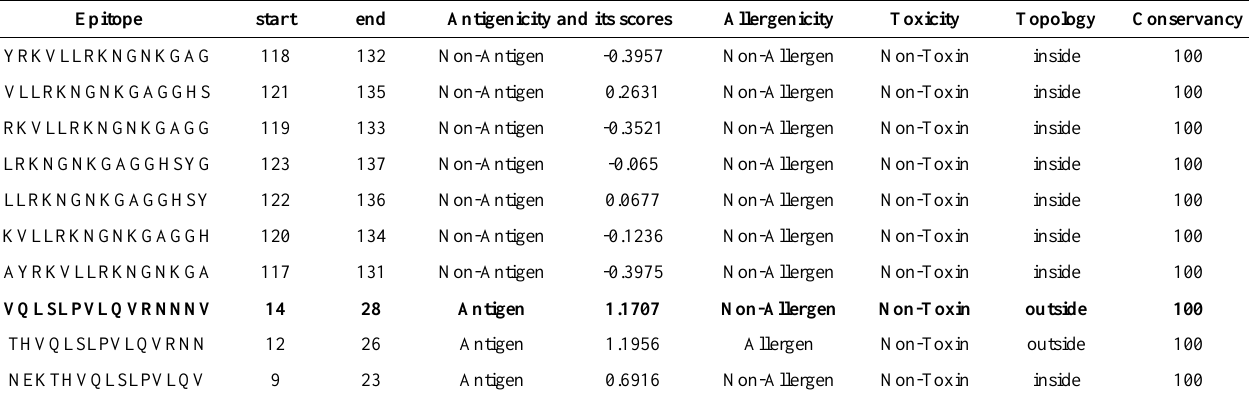
Table 7. List of MHC Class-II epitopes for selected leader protein ORF1ab MT326175 along with their antigenicity, allergenicity, toxicity, topology and conservancy scores. The epitope in bold italics is used for further 3D Structure